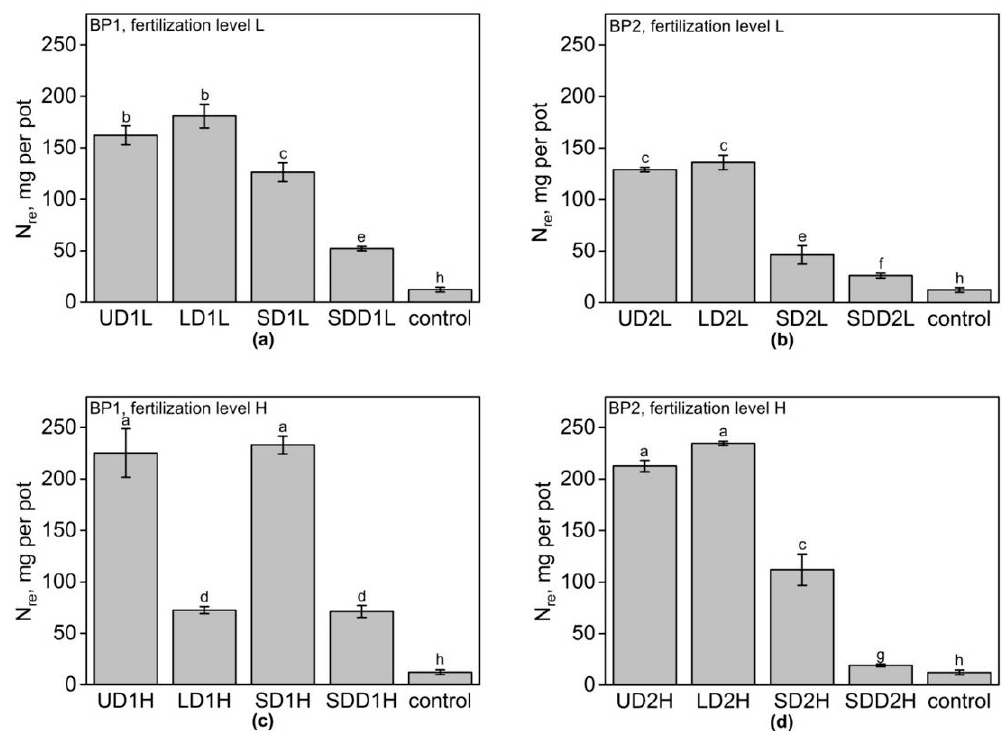
Figure 5. Nitrogen removal N re from soil substrate for different treatments: ( a ) Treatments based on manure as feedstock from BP1 with fertilization level L; ( b ) Treatments based on energy crops as feedstock from BP2 with fertilization level L; ( c ) Treatments from BP1 with fertilization level H; ( d ) Treatments from BP2 with fertilization level H; (code see Table 1; n = 4, whiskers show standard deviation, different letters indicate significant differences, p = 0.05).